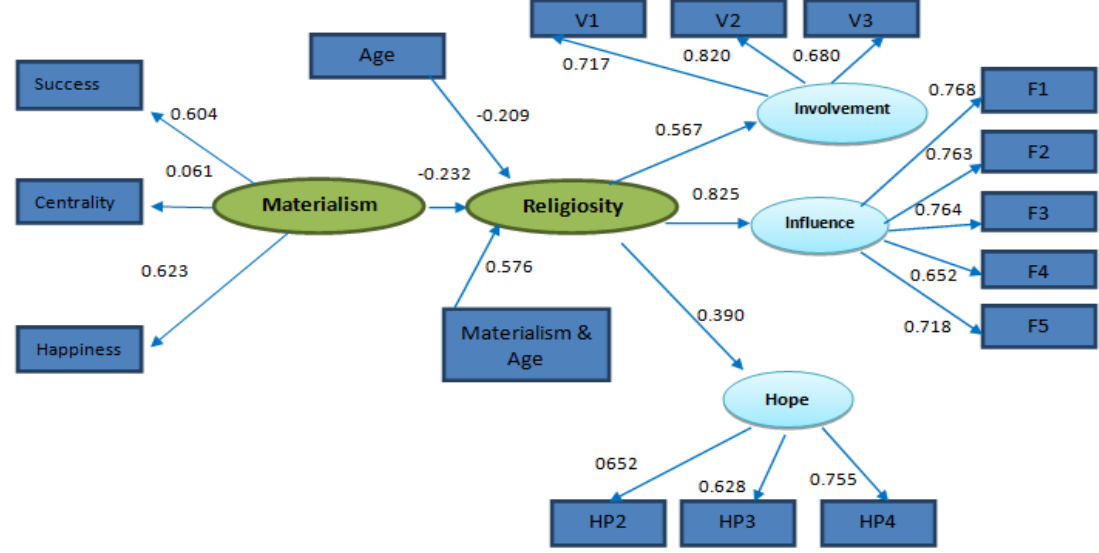
Figure 1. Materialistic value-orientation on Religiosity.